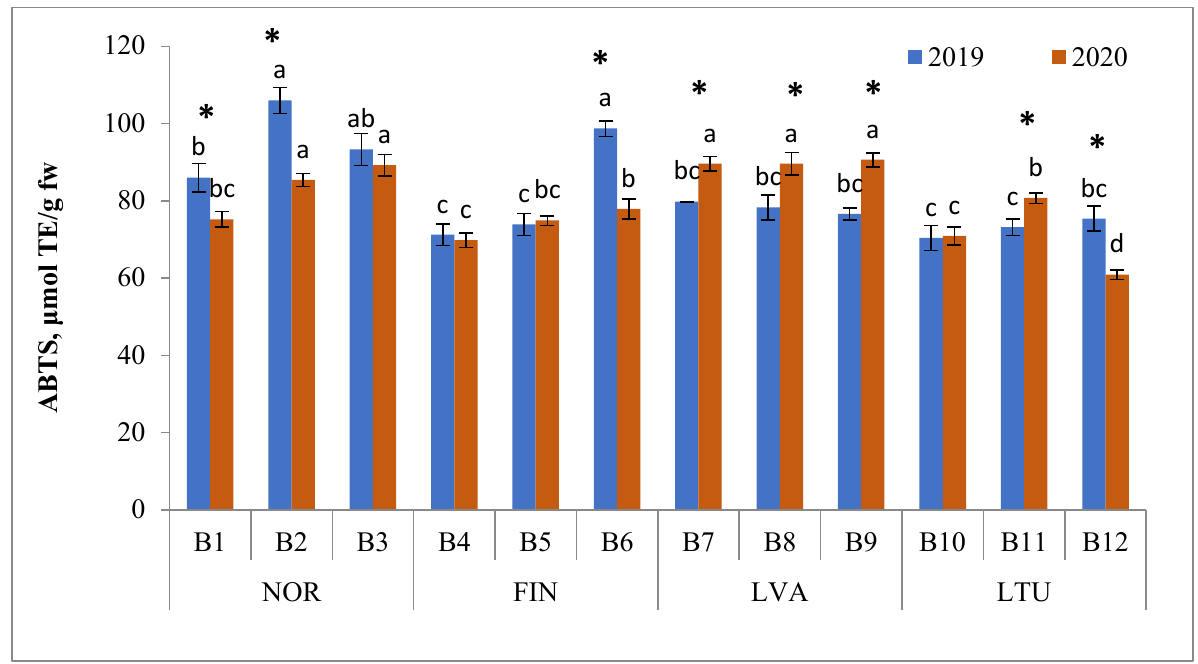
Figure 6. ABTS radical scavenging activity (RSA) of bilberries ( μ mol TE/g FW). Different letters above the same color bars indicate significant differences between the mean values ( p < 0.05). Significant differences between 2019 and 2020 are indicated by asterisks (*) ( p < 0.05). Locations of bilberry samples collection include Norway (NOR), Finland (FIN), Latvia (LVA) and Lithuania (LTU).